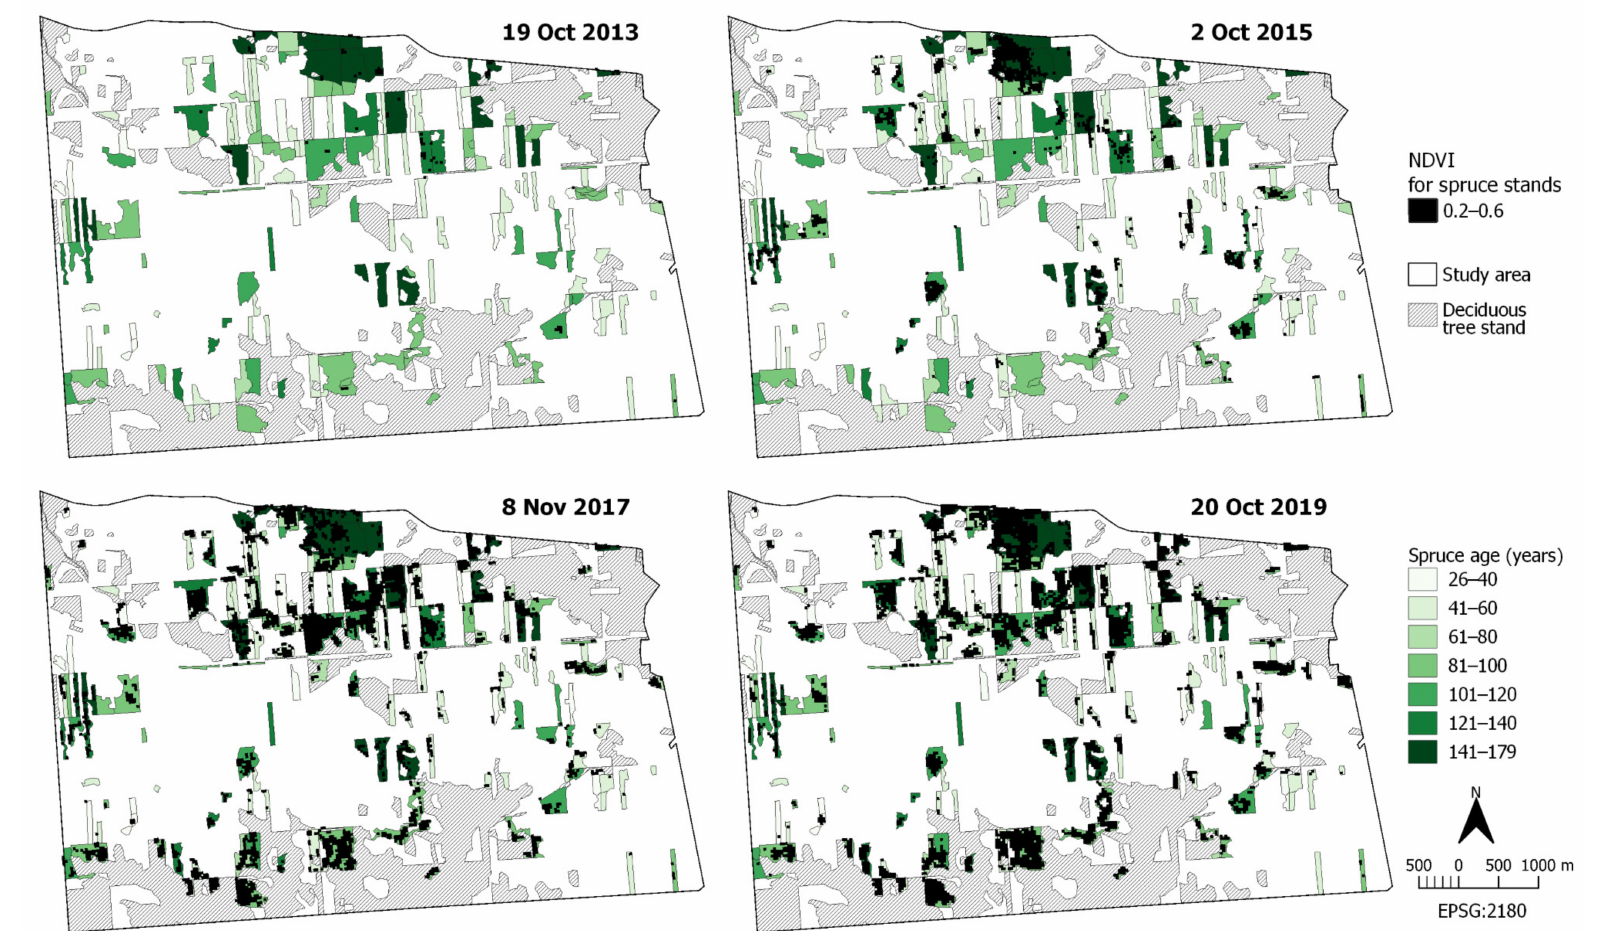
Figure 7. Areas of low values of NDVI in relation to the spruce stand age in 2013, 2015, 2017, and